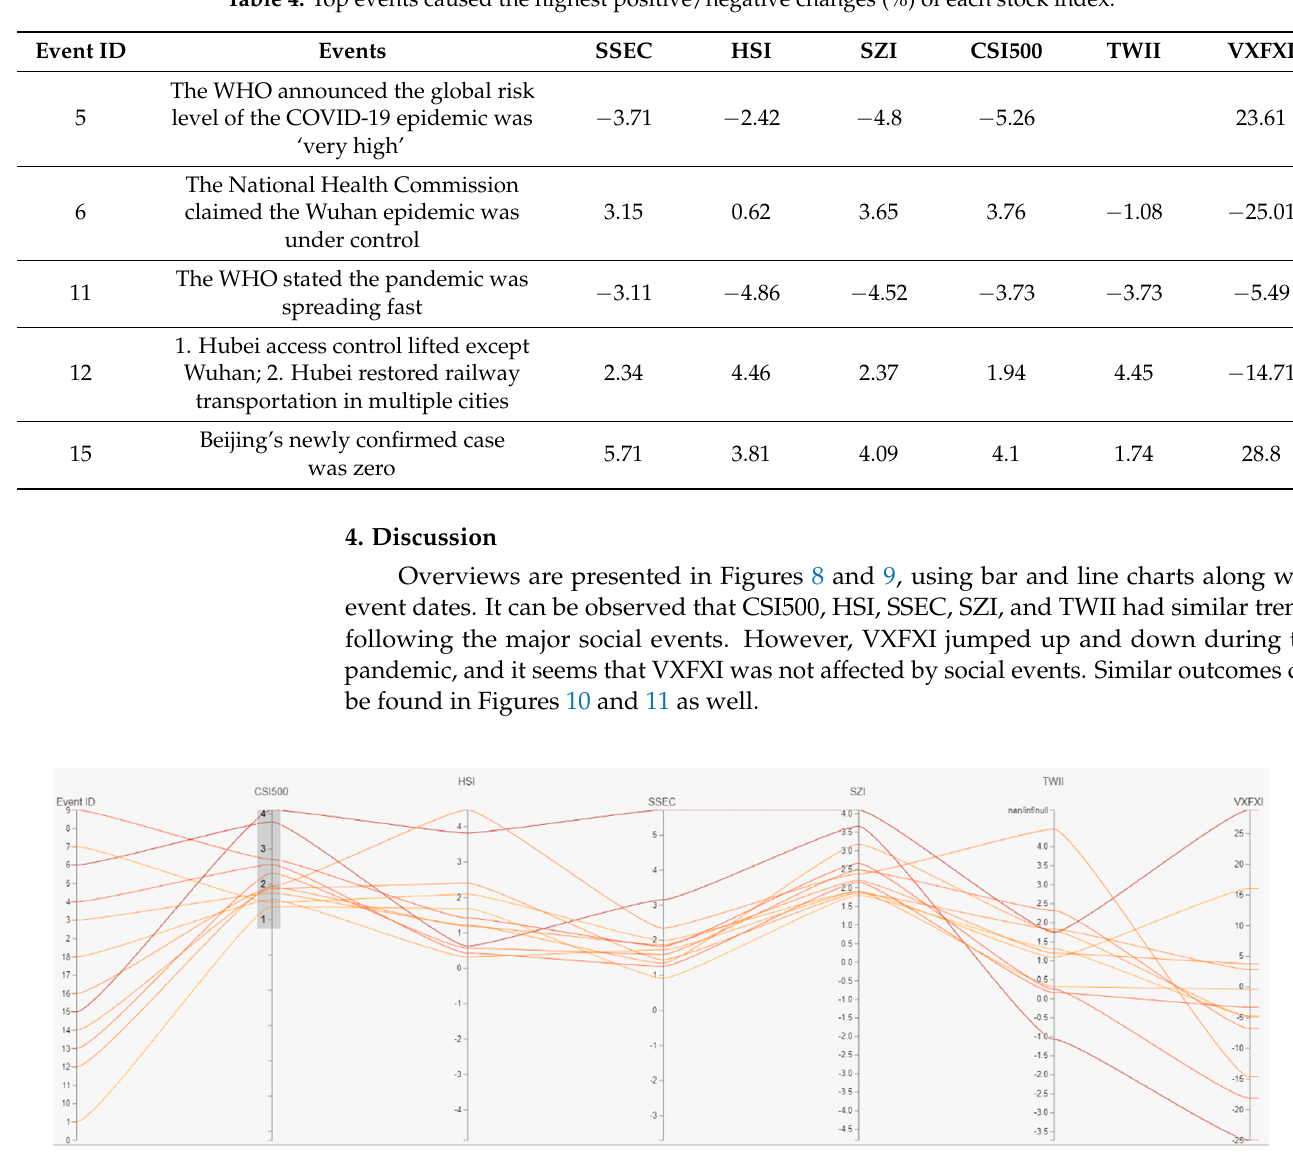
Table 4. Top events caused the highest positive/negative changes (%) of each stock index.